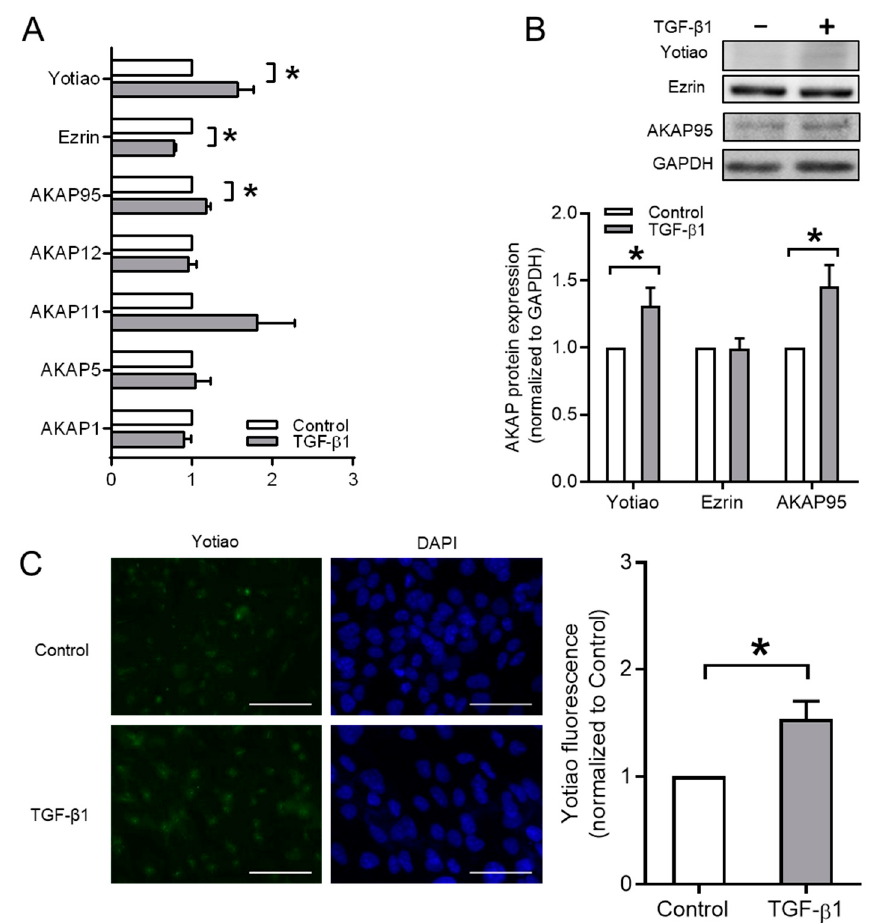
Figure 4. E ff ect of TGF- β 1 on gene and protein expression of A-kinase anchoring proteins (AKAPs) in BEAS-2B cells. ( A ) Gene expressions of AKAP1 , AKAP5 , AKAP11 , AKAP12 , AKAP95 , Ezrin , and Yotiao were studied by real-time quantitative PCR. ( B ) Representative western blotting images and quantification of Yotiao, Ezrin and AKAP95. ( C ) Immunofluorescence images of Yotiao after 3 ng / mL TGF- β 1 stimulation for 24 h. Scale bar represents 100 µ m. Data represent 5–7 independent experiments. Data are expressed as mean ± SEM, * p < 0.05; significant di ff erence between indicated groups.